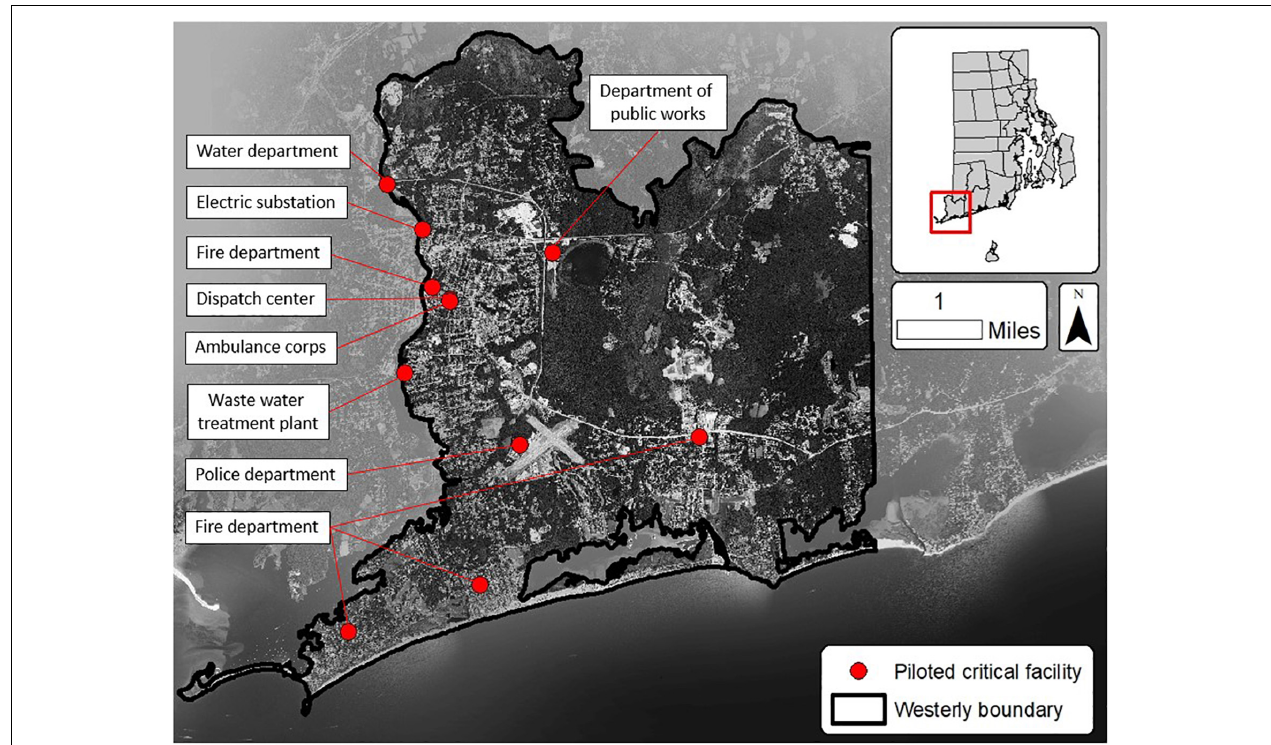
FIGURE 1 | Westerly, RI critical facilities included in pilot study (Image: authors, data from